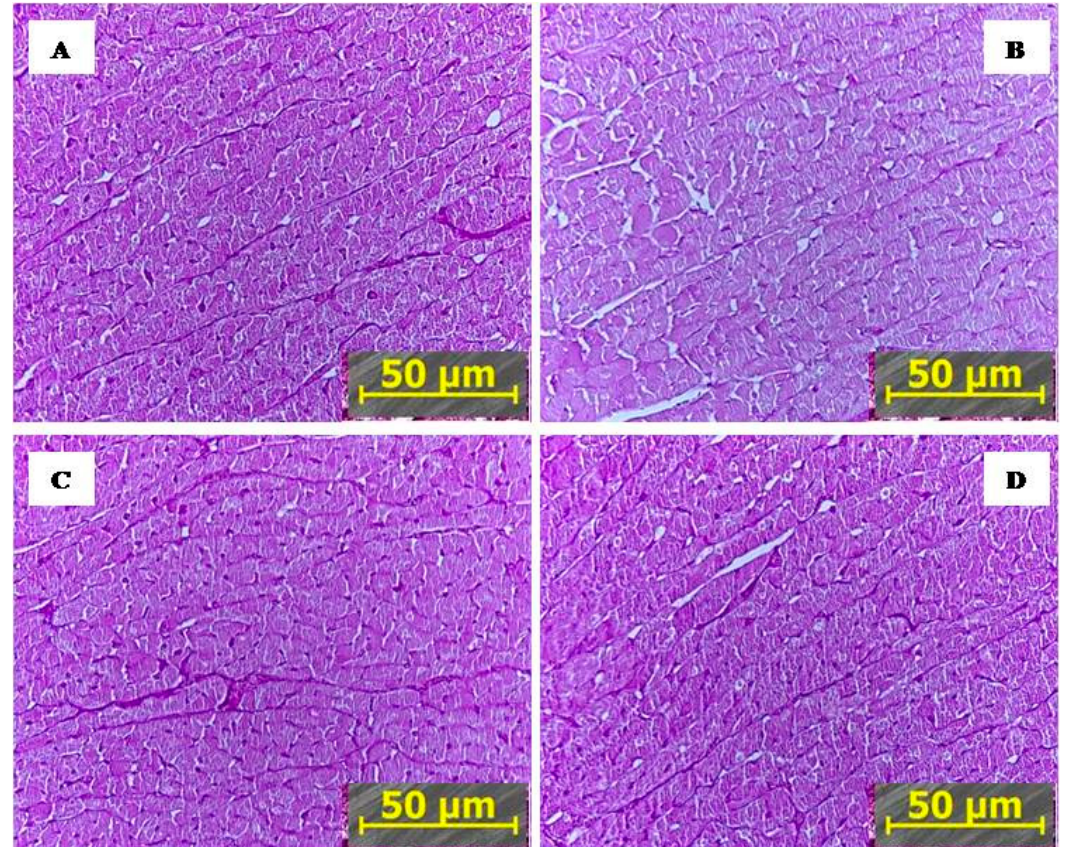
Figure 2. Representative microscopy of glycogen in the rat heart, cross sections (Chic reaction). ( A ) control, ( B ) PTSD; ( C ) IHC, ( D ) PTSD+IHC. Arrows indicate cells deprived of glycogen. Magnification ×200.